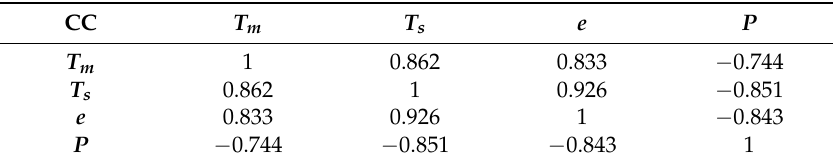
Table 3. CCs of various meteorological